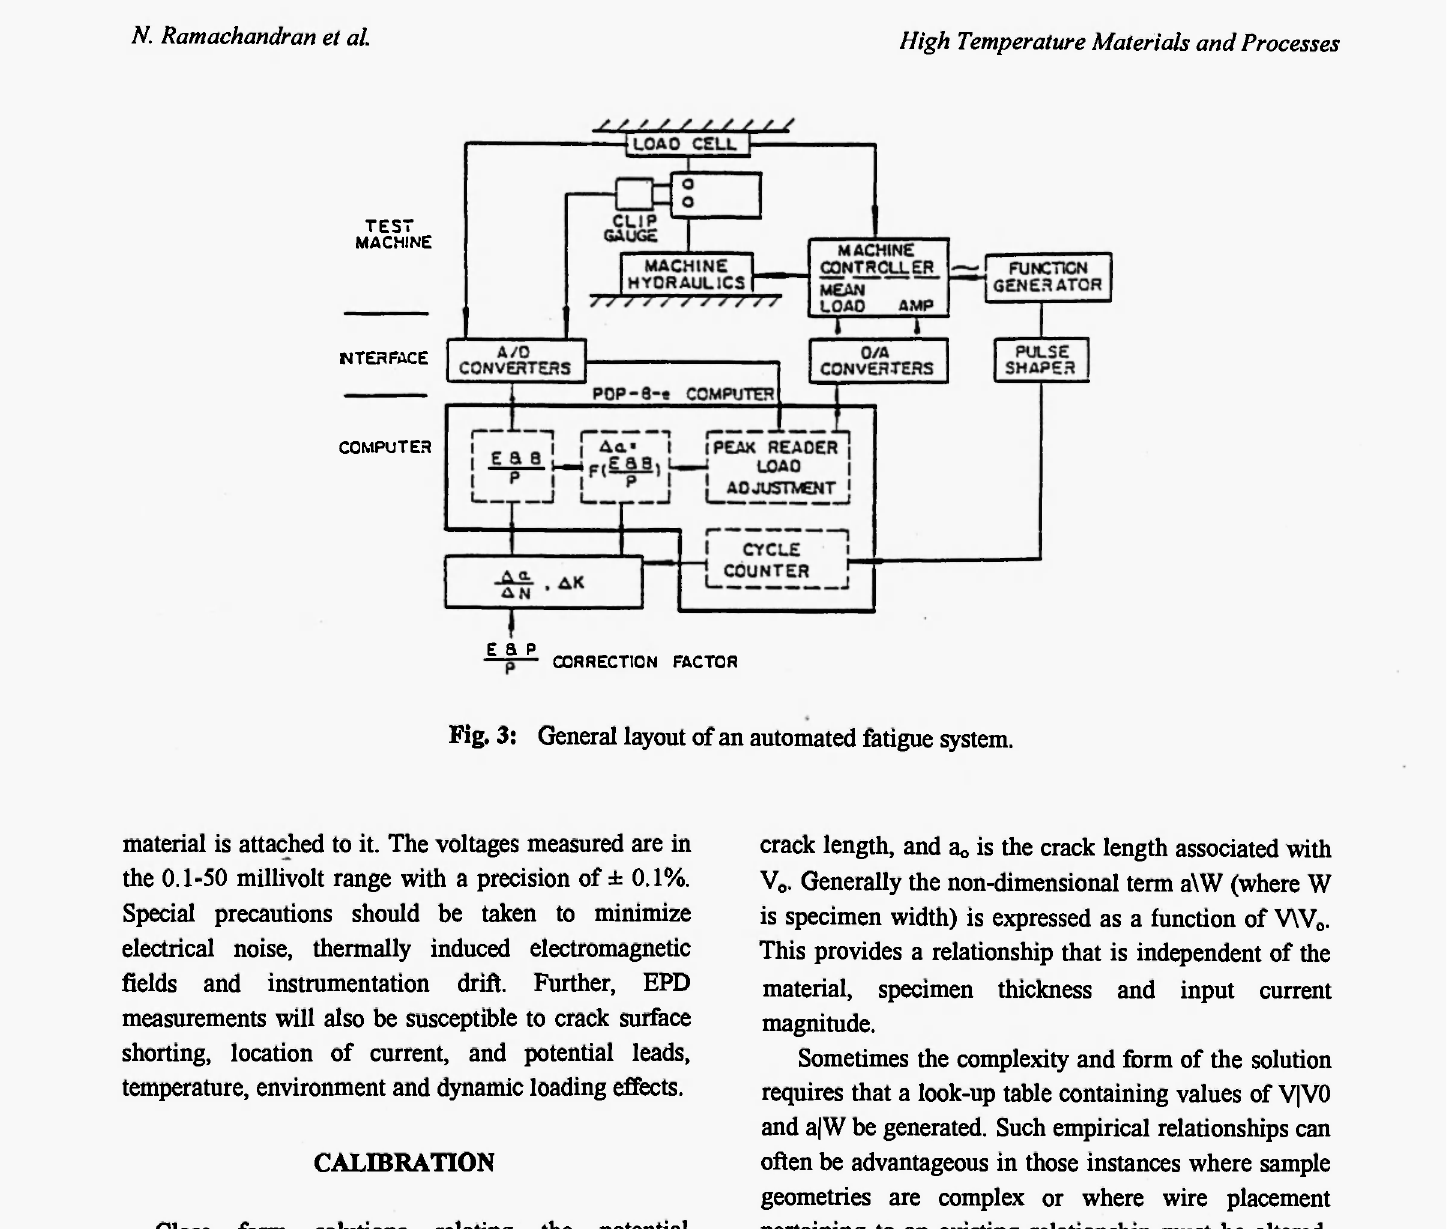
Fig. 3: General layout of an automated fatigue